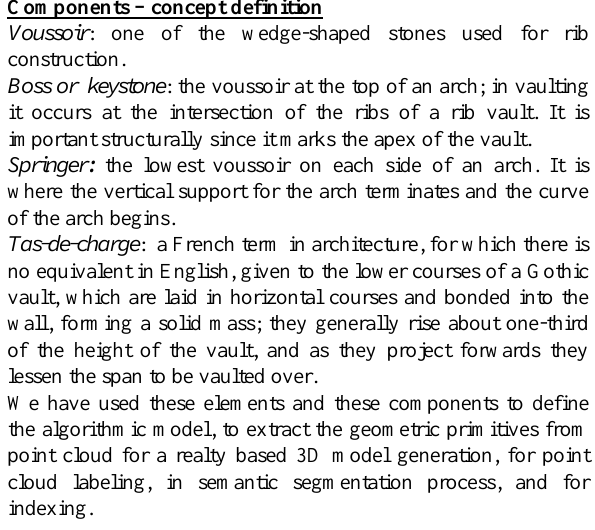
Figure 4 . Main components